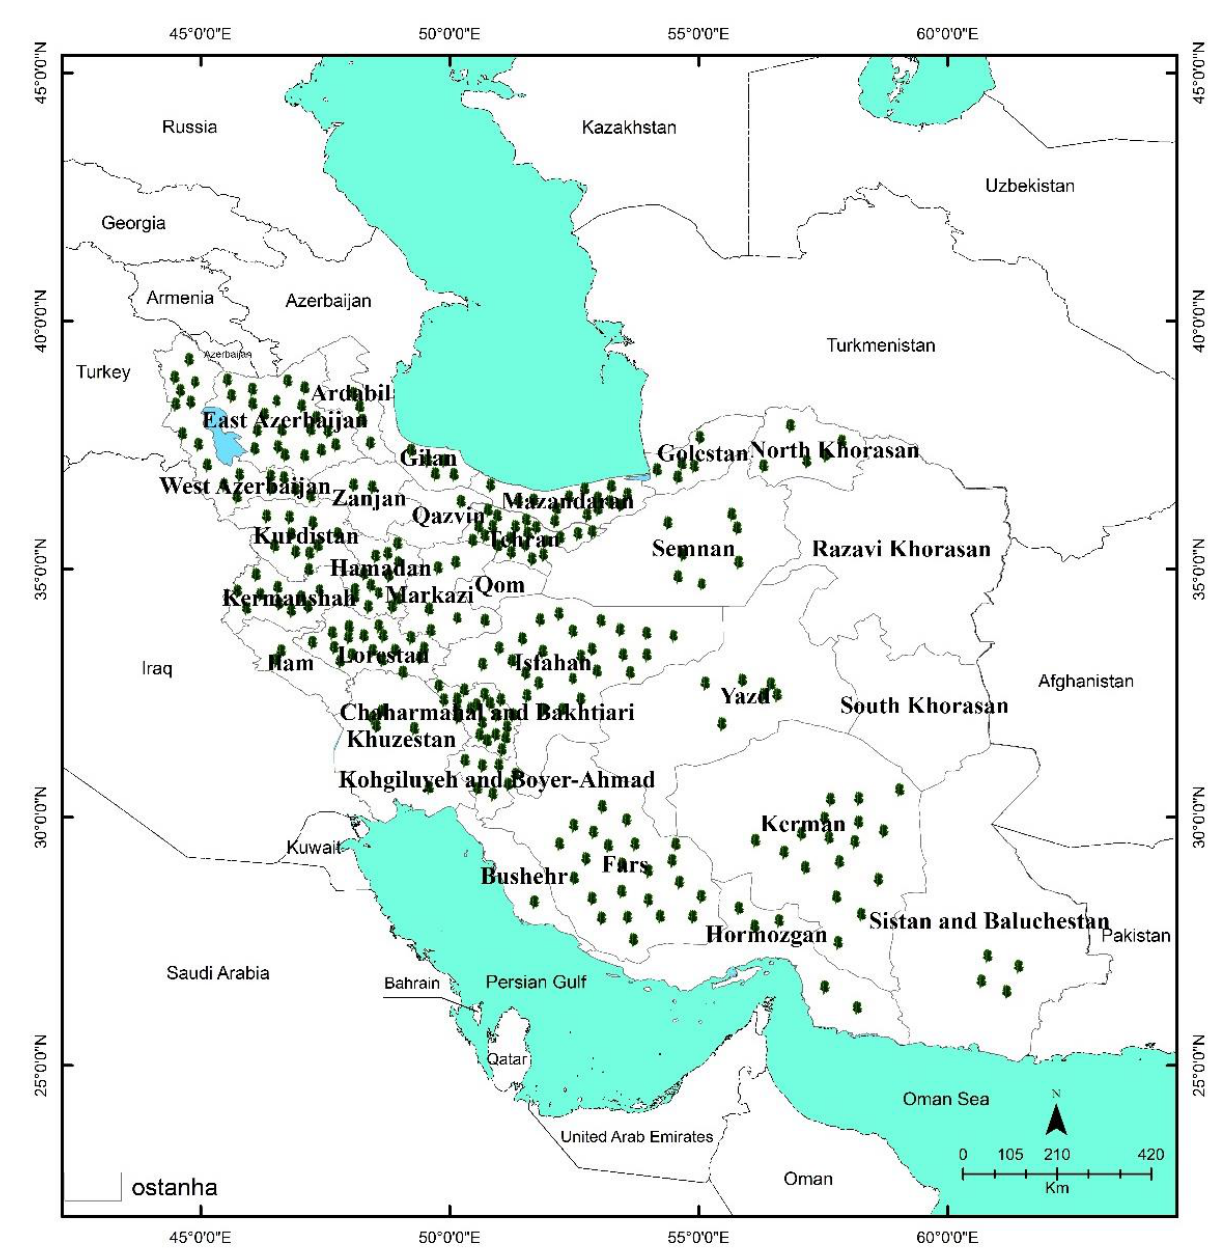
Figure 4. The distribution pattern of Iranian endemic medicinal and aromatic plants across the prov- inces.